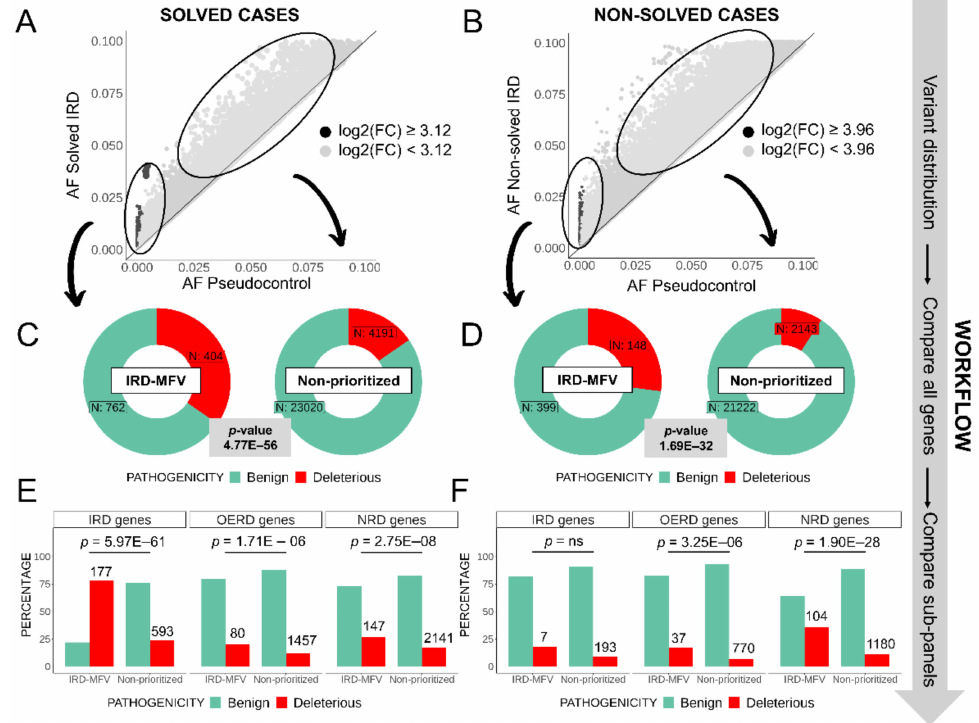
Figure 2. Comparison of the percentage of deleterious variants in prioritized and non-prioritized variants in solved and non-solved IRD patients. Variant AFs are compared in inherited retinal dystrophies (IRD) solved ( A ) and non-solved ( B ) subcohorts against pseudocontrols (PC) using fold changes (FC). IRD more frequent variants (IRD-MFVs), highlighted in dark, were defined using FC thresholds at 0.90 percentiles of all FC in each comparison ( A , B ). Proportion of deleterious and benign variants in both solved ( C ) and non-solved IRD cases ( D ) and the p -values representing the enrichment of deleterious variants in IRD-MFVs. Enrichment analyses are also performed dividing the IRD-MFVs according to the genes in which they are located; they are grouped into IRD genes, other eye-related diseases (OERD genes), and other non-eye-related diseases (NRD genes) ( E , F ). Total number of deleterious variants in each group is noted at the top of the red bars. Non-significant p -values are marked as